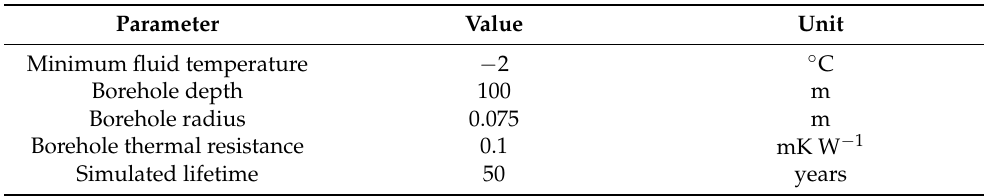
Figure 2. ( a ) Climate zones of Italy as defined by the Presidential Decree [55] (modified from [56]); ( b ) location of the five meteorological stations located in, or near, the study area; ( c ) mean temperatures of recorded by the five meteorological stations for the 2009–2019 period. Table 2. Closed-loop borehole heat exchanger (BHE) systems and heat-exchange parameters used in the Geothermal POTential (G.POT) algorithm.